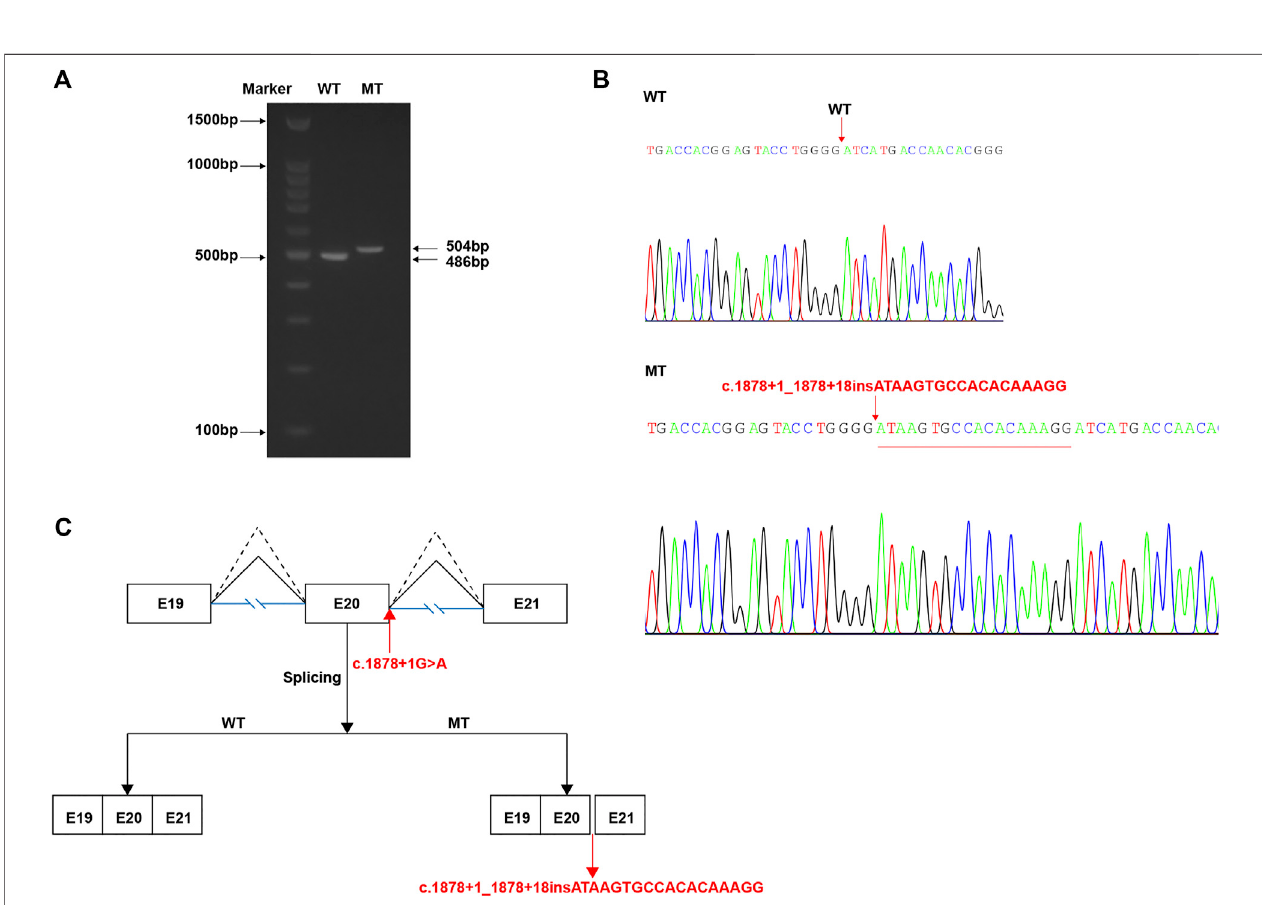
FIGURE4| Invitro studyofthec.1878+1G > Avariant. (A) Aftertransfectionwithwild-type(WT)ormutant(MT)vectors,RNAextraction,andreversetranscription, the product results of PCR ampli fi cation of target region displayed by agarose gel electrophoresis. (B) Sanger sequencing results of cDNA corresponding to the ampli fi cation products in (A) , indicating a 18 bp insertion. (C) The schematic demonstrating the proper (WT, dotted broken lines) and abnormal (MT, full broken lines) splicing patterns by each vector.